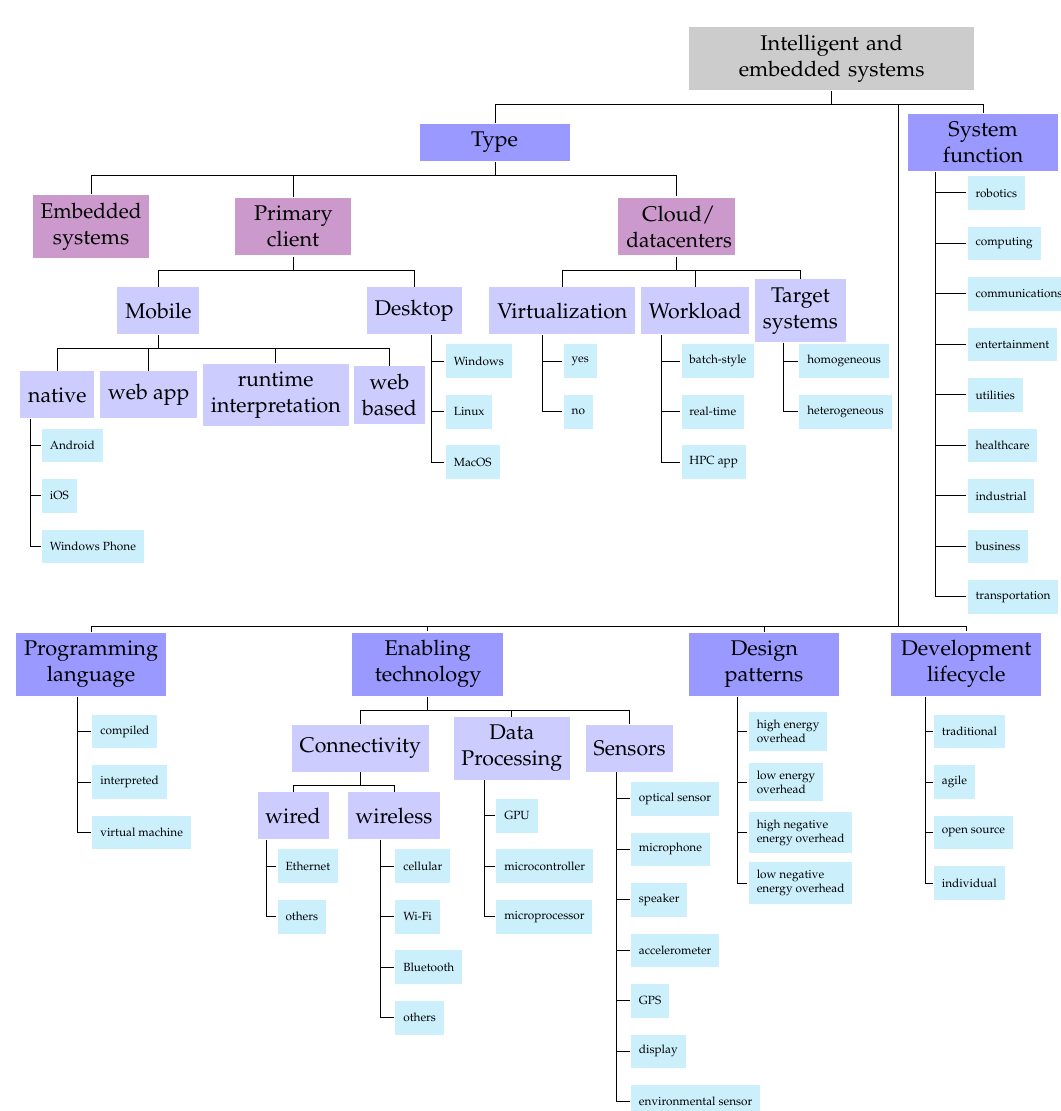
Figure 6. Computer system classification tree from the energy efficiency